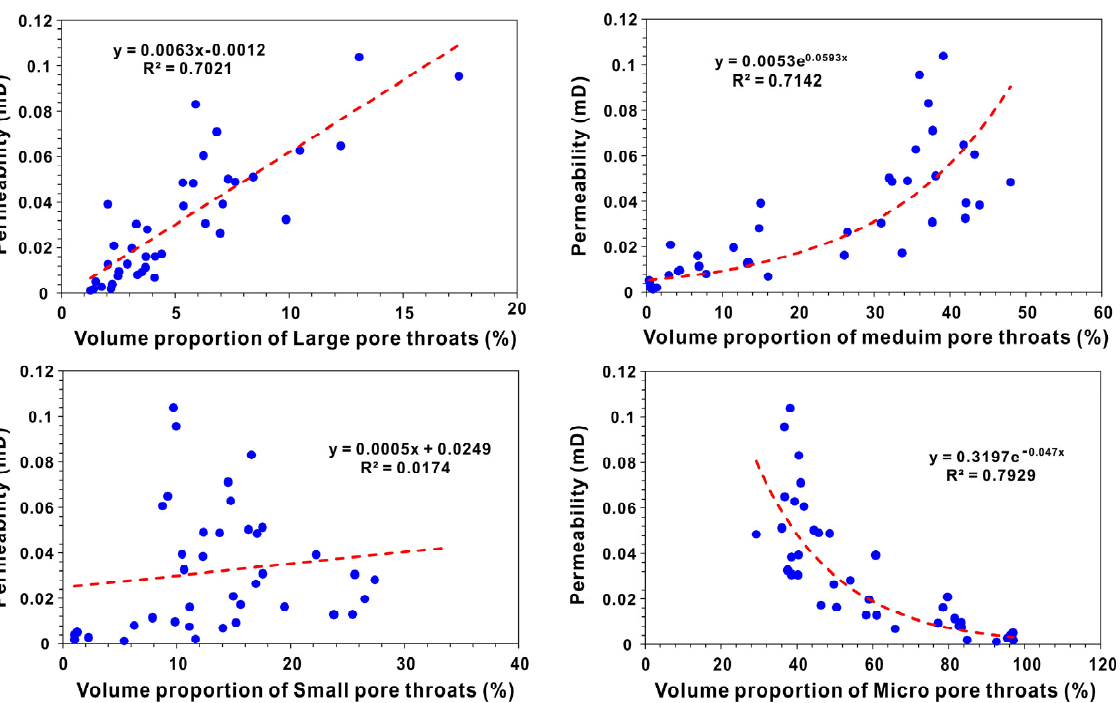
Figure 5. Relationships between the permeability and different pore throats of the Chang 7 1-2 sub-member shale oil reservoirs.